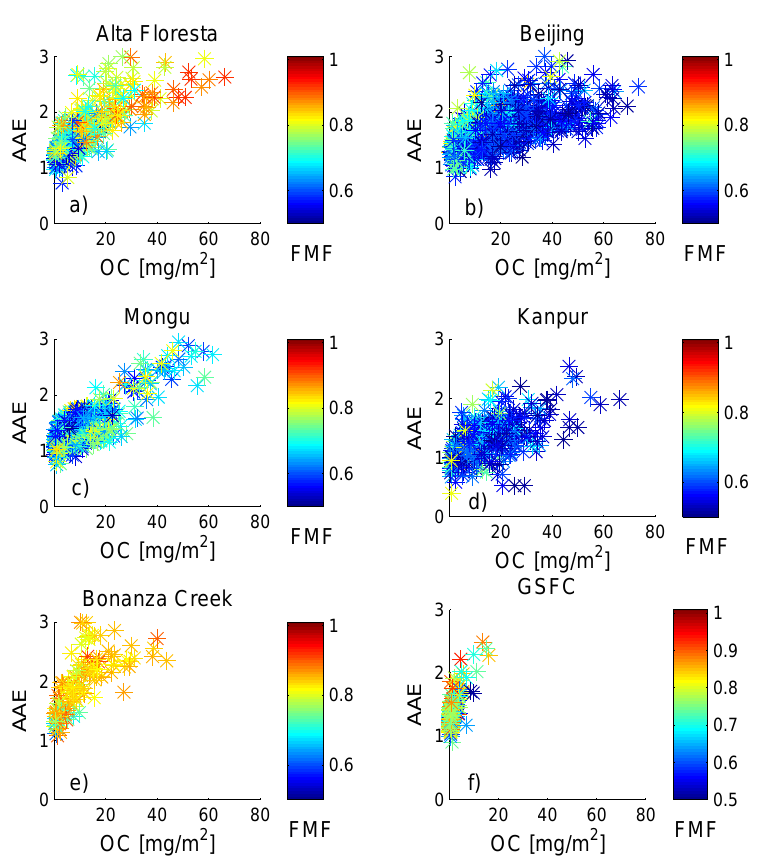
Fig. 1. Absorbing OC column concentrations [mgm − 2 ] as a function of AAE from 440/670nm wavelength pair and the ratio of fine mode to total volume concentration, fine mode fraction (FMF) shown as color. Name of the site is indicated at the top of each subplot.